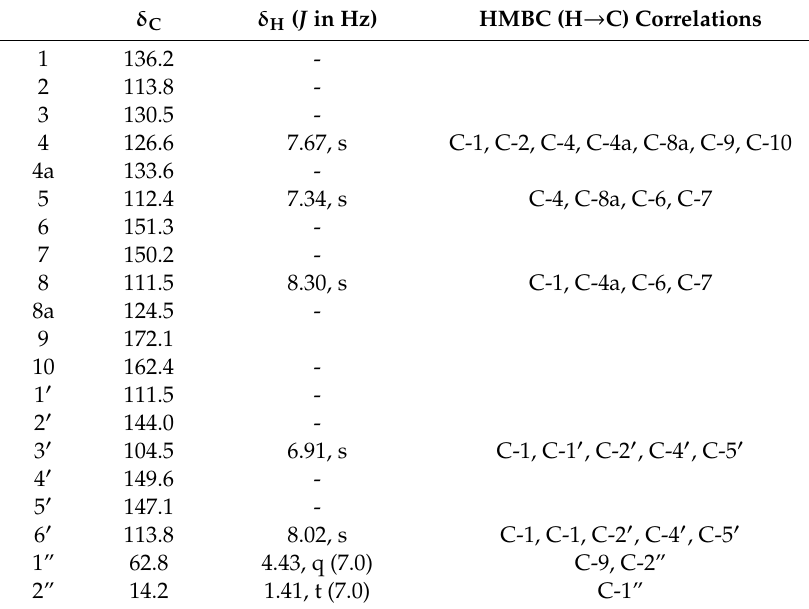
Table 2. 13 C (150 MHz) and 1 H NMR (600 MHz) data of compound 15